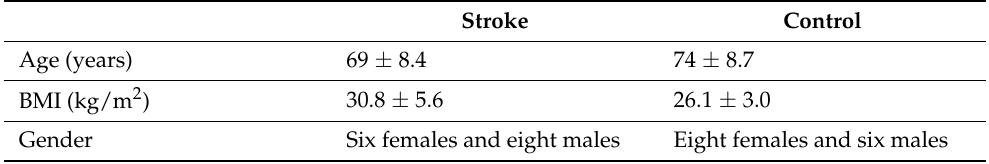
Table 3. Anthropometric data of individuals with stroke and healthy adults. Table 4. Fugl–Meyer scores of fourteen healthy and fourteen stroke participants.